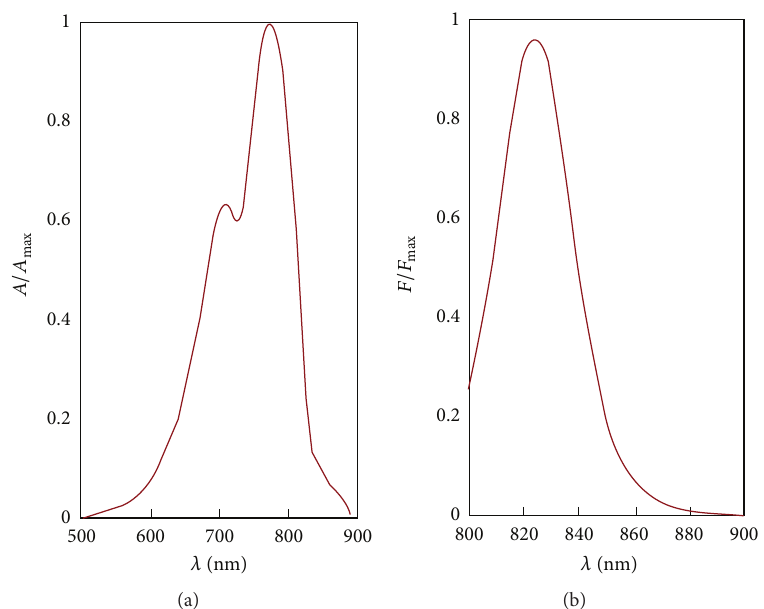
Figure 1: (a) UV-Vis spectrum and (b) fluorescence spectrum of aqueous solution of ICG 25 𝜇 M at 30 ∘ C.